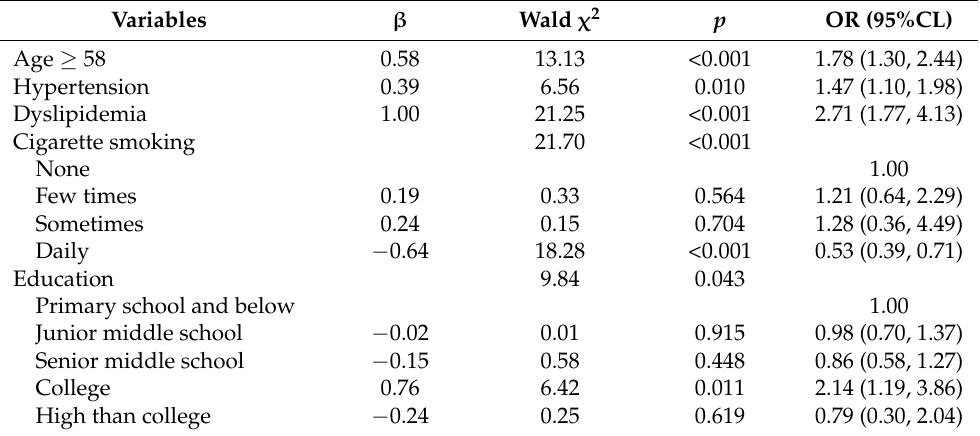
Table 3. Logistic regression showing predictors of normal weight central obesity in males.